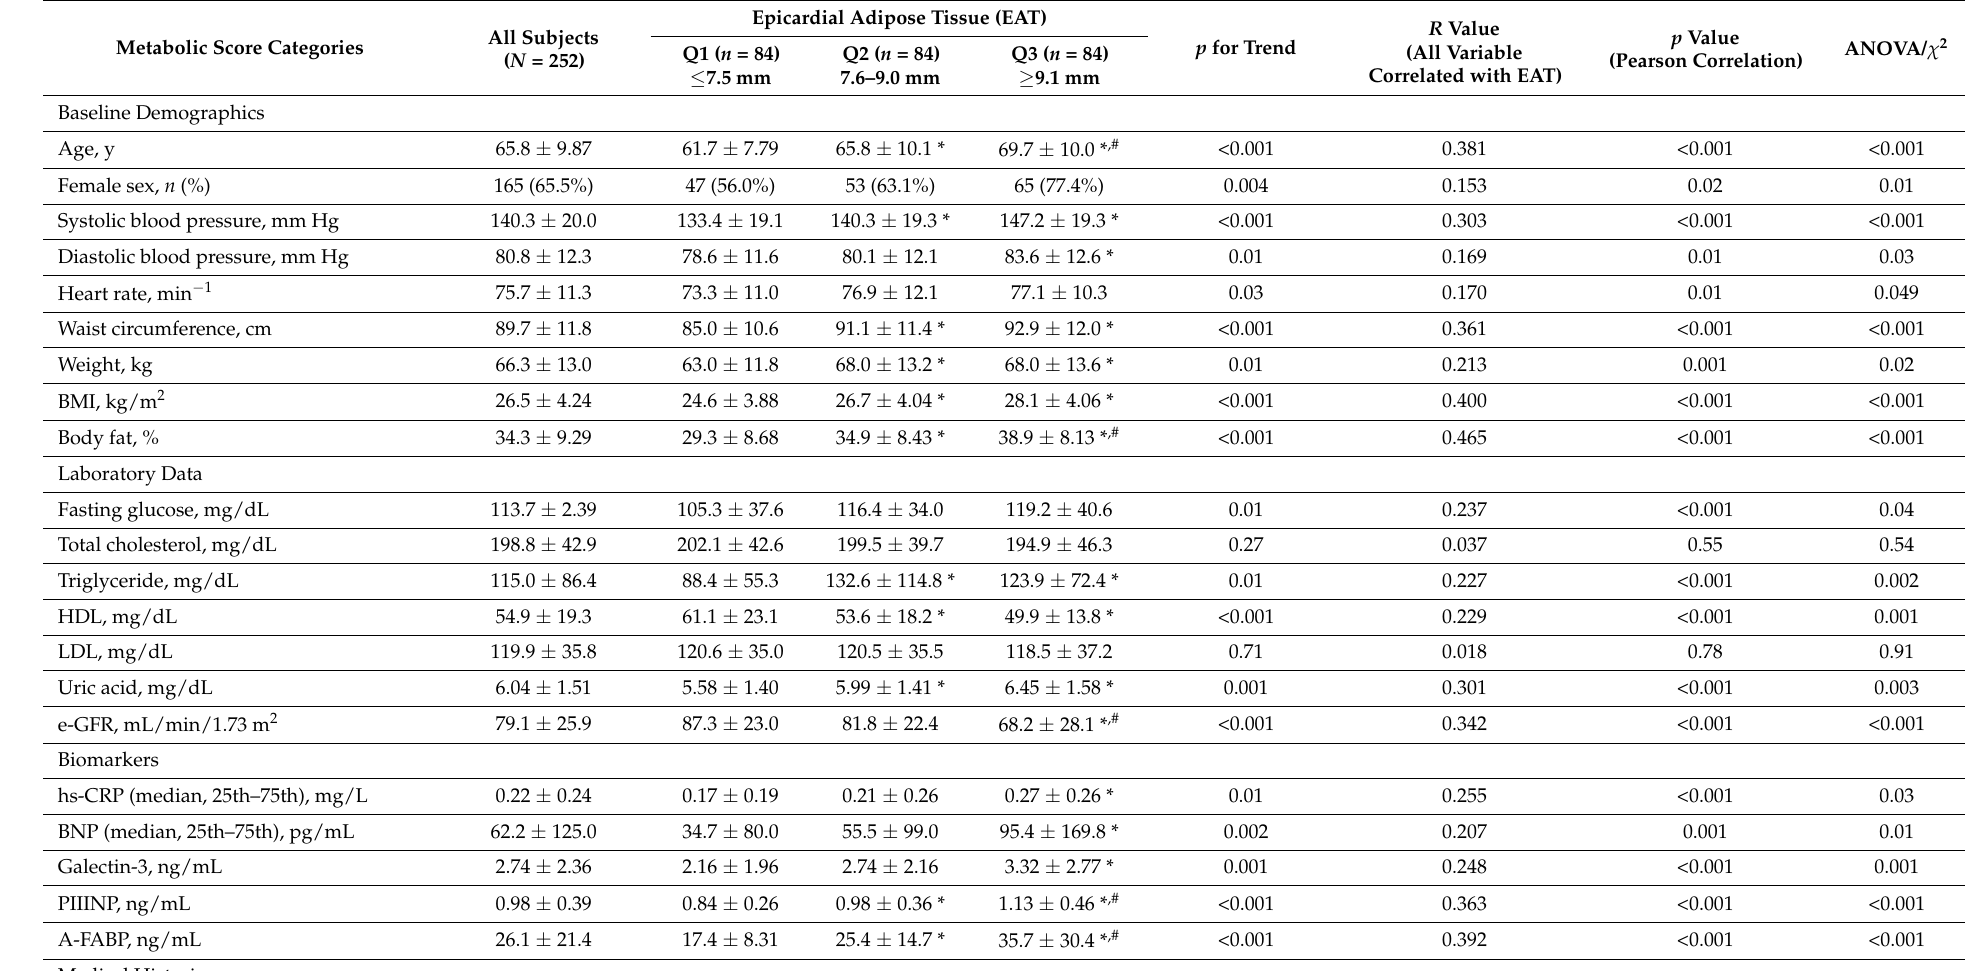
Table 1. Clinical demographics and echocardiographic measures of participants categorized by EAT tertile